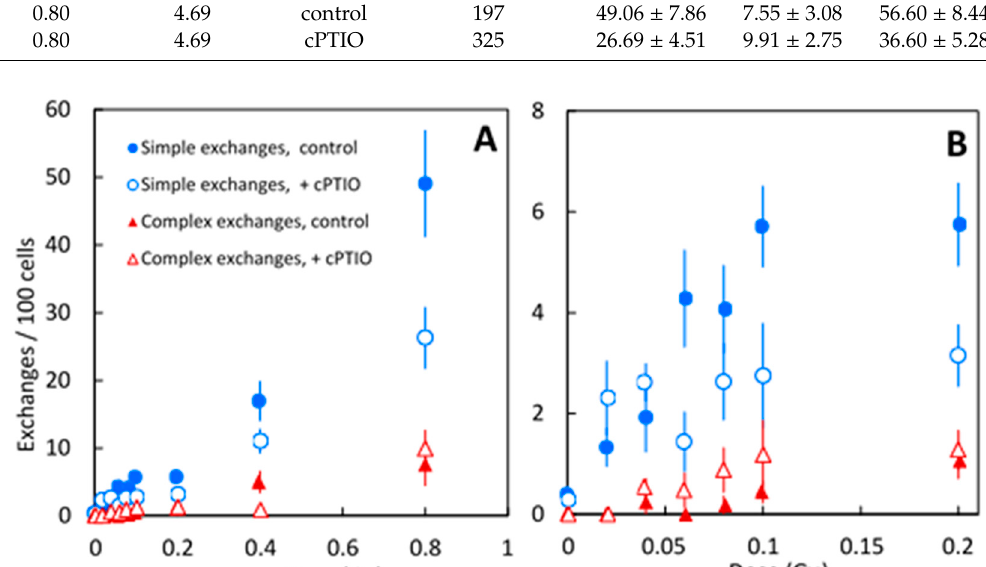
Figure 4. Graphical representation of the data shown in the Table 2. Frequencies of simple and complex types of chromosome exchanges exposed to Fe-ions (600 MeV/u) with or without the NO-scavenger cPTIO. A : Results across all doses. B : Results at lower doses. Error bars indicate the standard error of the mean values.